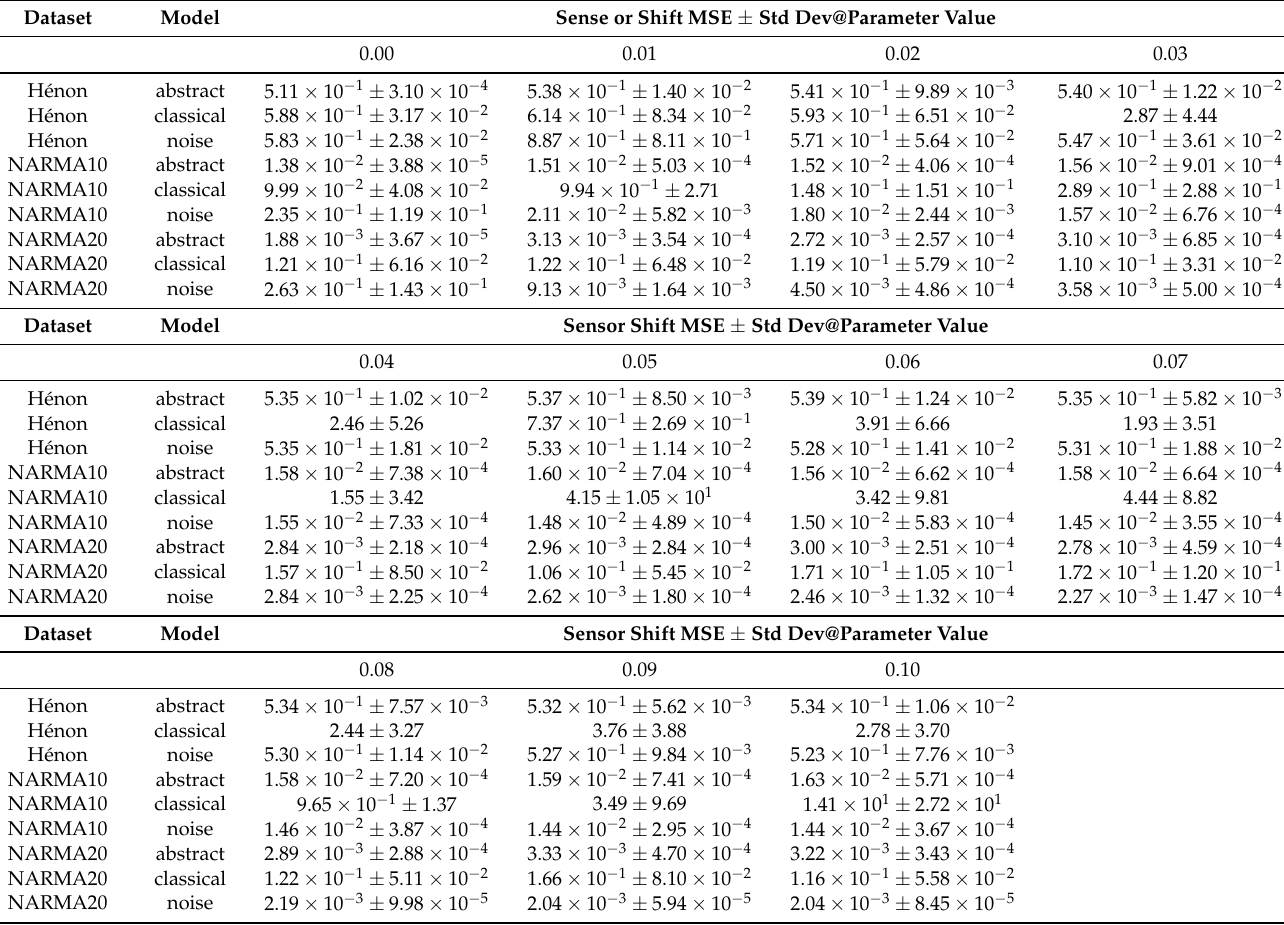
Table A3. Average MSE for the experiments simulating a sensor reading shift over 10 experiment runs. The parameter gives the shift that was added to the sensor readings.